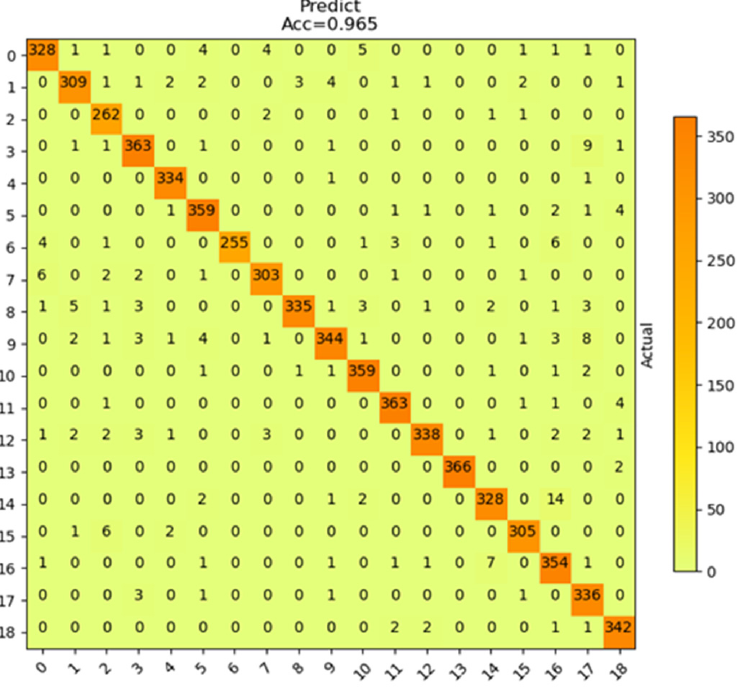
Figure 16. MFSwin-T Confusion matrix.